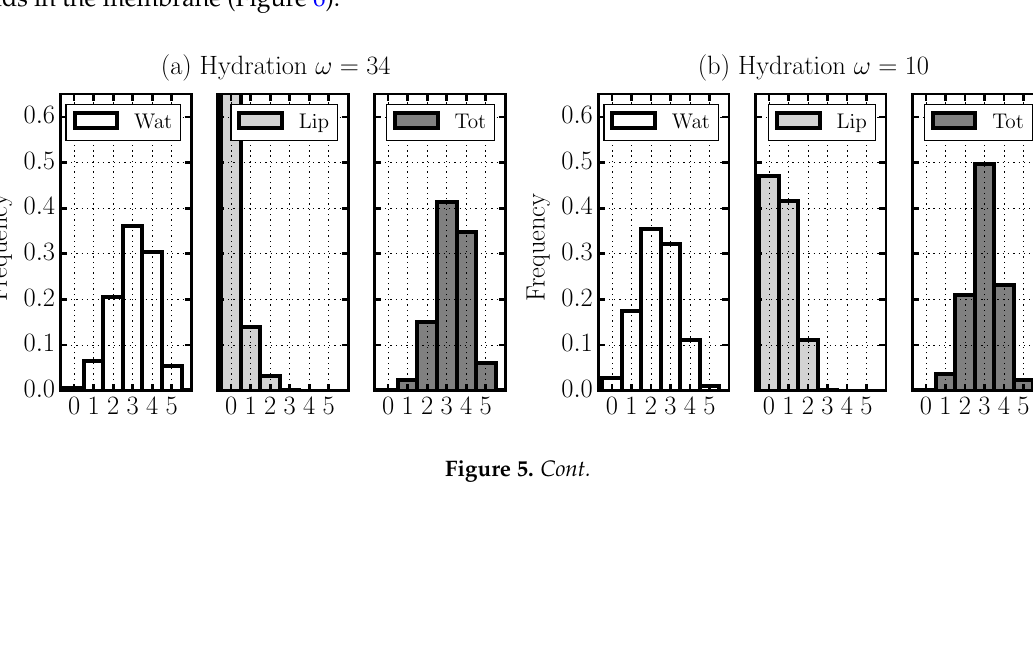
Figure 4. Changes in HB structure with hydration level ω . ( a ) average number formed by each water molecule confined in stacked phospholipid membranes; ( b ) fraction of HBs between water molecules and lipid groups.